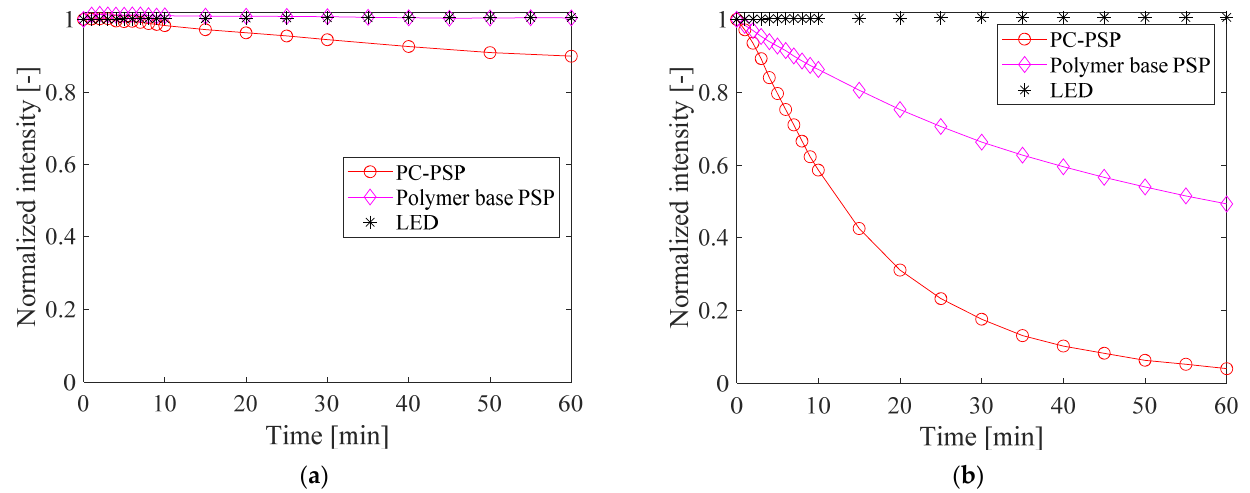
Figure 9. Photostability of PC-PSP after the heat treatment at ( a ) 20 °C and ( b ) 100 °C.